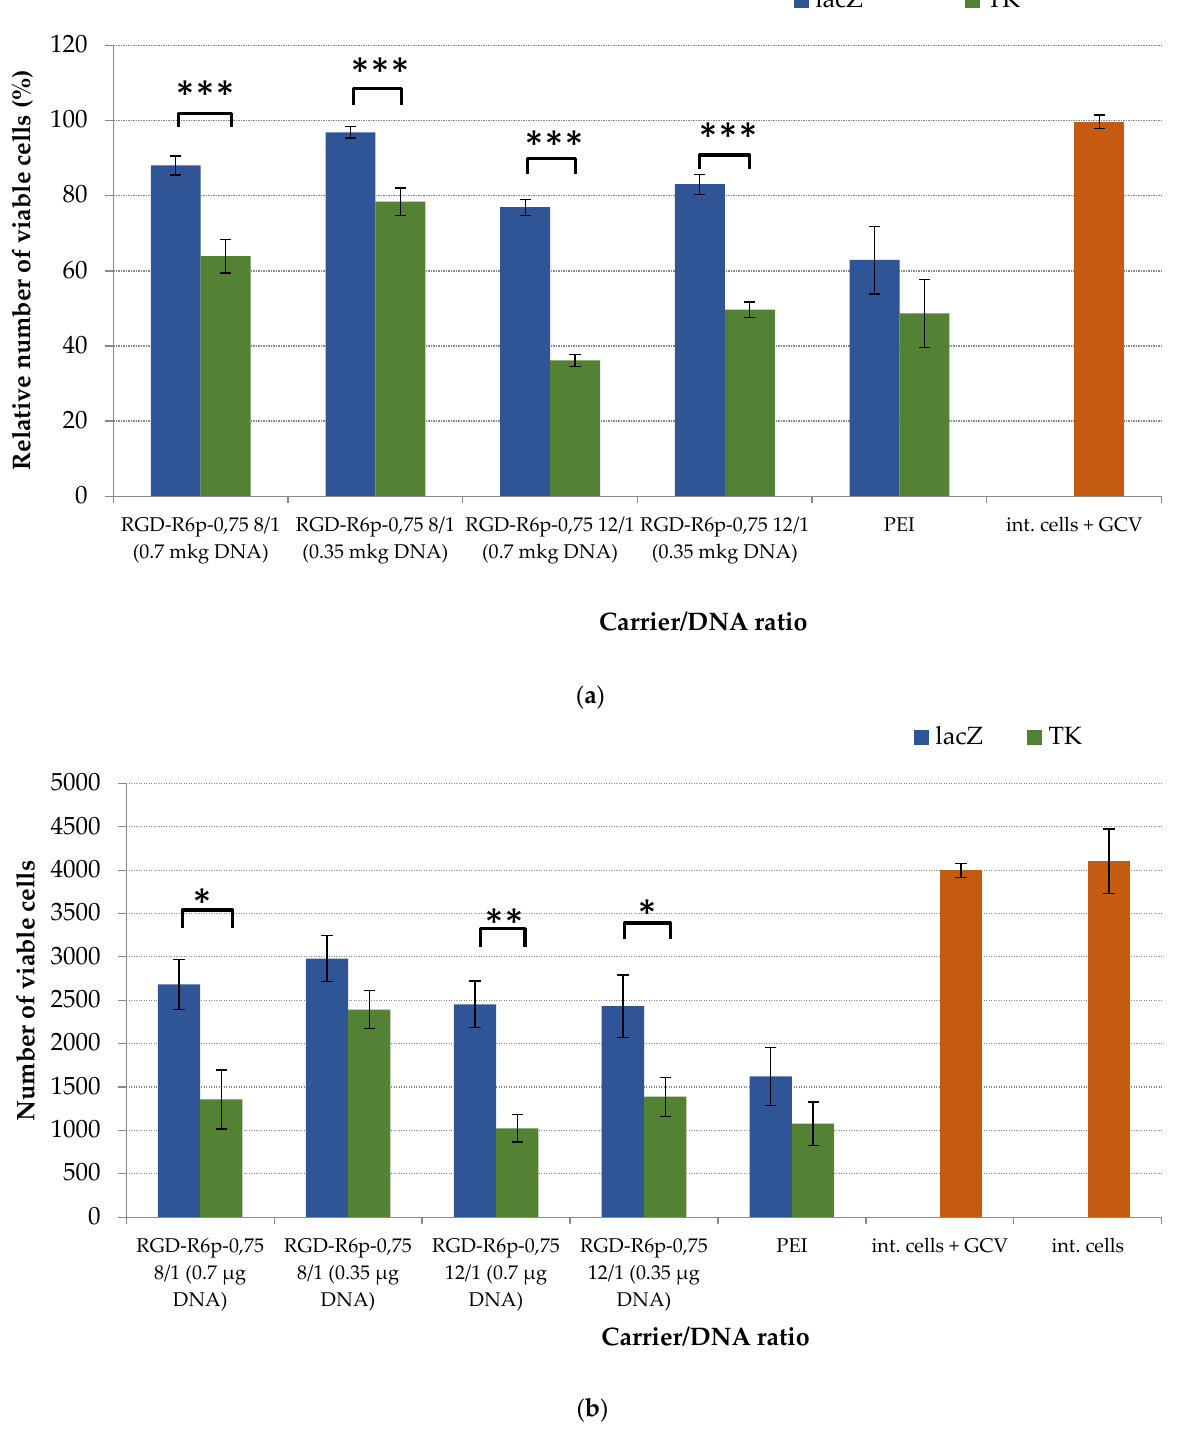
Figure 9. Relative UL cell viability ( a ) and a number of viable UL cells ( b ) after HSV thymidine kinase expression and GCV treatment. Values are the mean ± SD of the mean of triplicates. * p < 0.05, ** p < 0.01, *** p < 0.001 compared to pCMV-LacZ-complexes. An alamarBlue assay revealed that after cell transfection with RGD-R6p-0,75-polyplexes and subsequent cell incubation with GCV, the intact cells and pCMV-LacZ-containing cells were insensitive to GCV treatment, whereas the HSV-TK